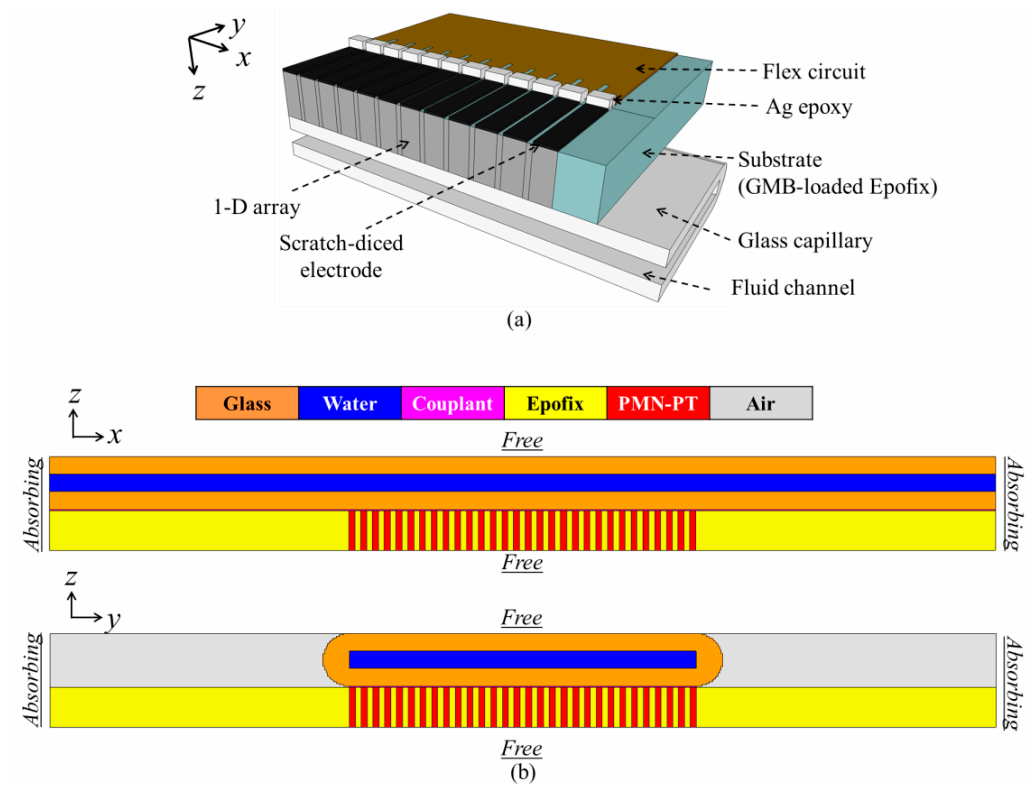
Figure 8. ( a ) Diagram of a quarter of a 1-D ultrasonic transducer array coupled to a glass capillary; ( b ) 2-D PZFlex models of the device in xz -plane cross-section, where each PMN-PT pillar indicates one array element, and yz -plane, where all 30 PMN-PT pillars are within the outline of one array element.